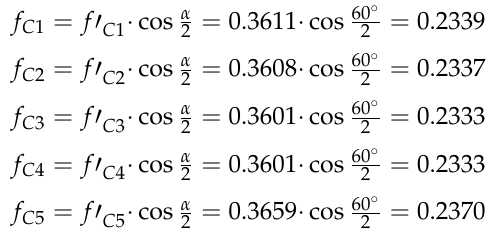
Figure 11. Dependence of emerging force F OC on time.